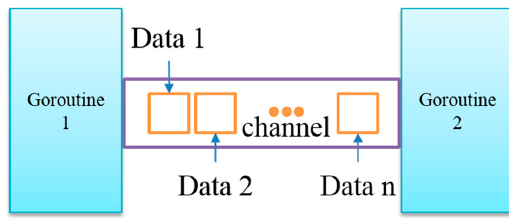
Figure 1. The communication process of two goroutines.